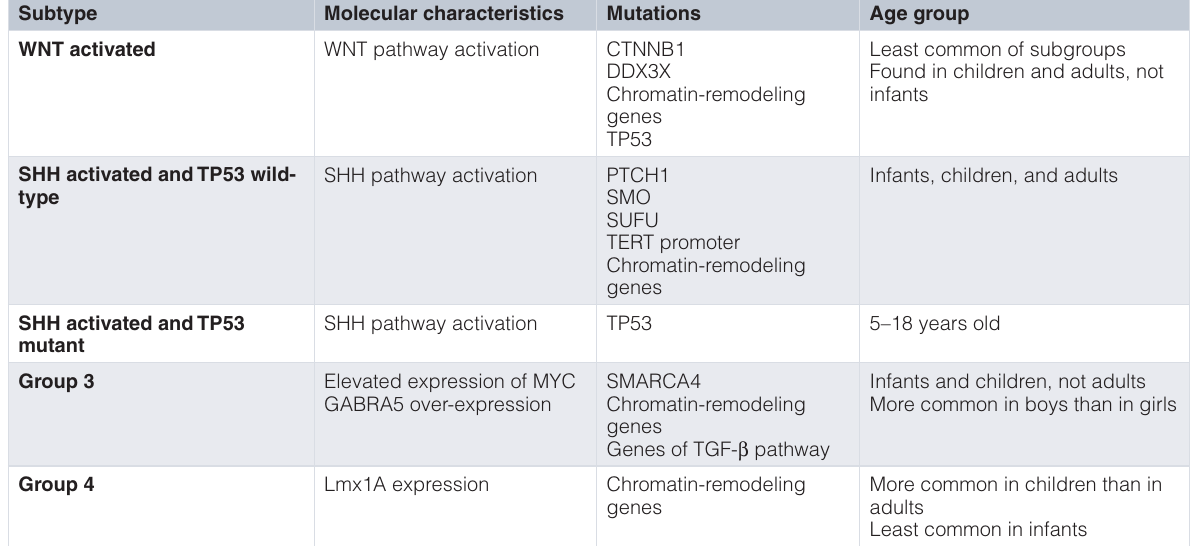
Table 1. Features of medulloblastoma